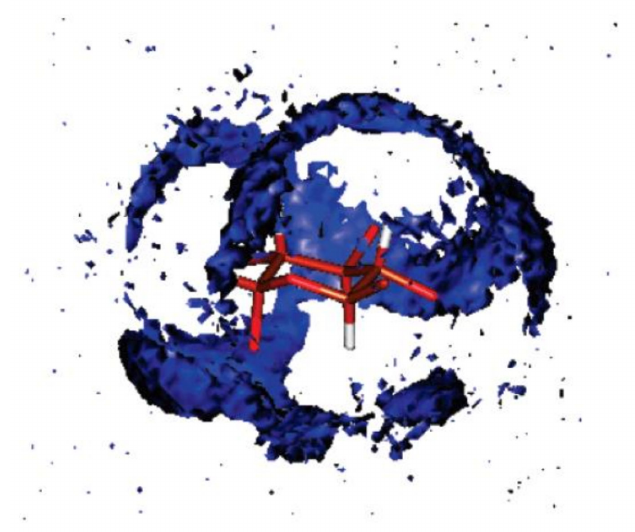
Figure 14. Spatial distribution function of the oxygen of water around glucose representing the probability of finding the oxygen atom of a water molecule at a given point in space around glucose. For clarity, the hydroxyl hydrogen and the hydroxymethylene hydrogen and oxygen atoms have been removed. This view shows the hydroxymethylene carbon and the ring oxygen at the forefront. Reproduced from Bagno et al. [114] with the permission of the American Chemical